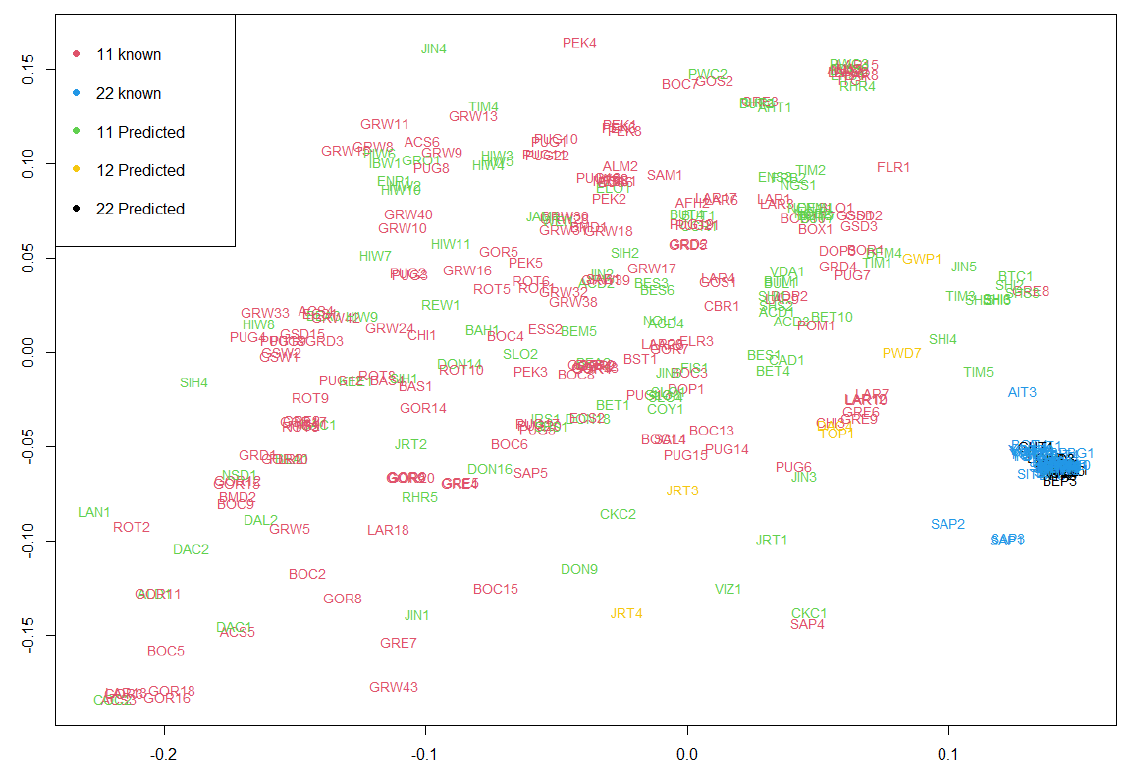
Figure 5. Multidimensional scaling plot of dog breeds with various hair lengths according to SNP variations. The plot was created on the basis of pairwise distances calculated from SNPs of the haplotype block 20 (CFA13:8,530,000 − 8,730,000 bp) linked to the RSPO2 3' UTR region. The genotypes of RSPO2 3' UTR in the top left of the plot were described as follows: “11” for homozygotes of the RSPO2 - wildtype allele, “22” for homozygotes of the RSPO2 - repeat allele, and “12” for heter- ozygotes. The words “known” and “predicted” indicate the use of available data (Cadieu et al. 2009) a nd prediction using the linkage analysis in this study, respectively. For information on the abbreviation of each breed, refer to Table